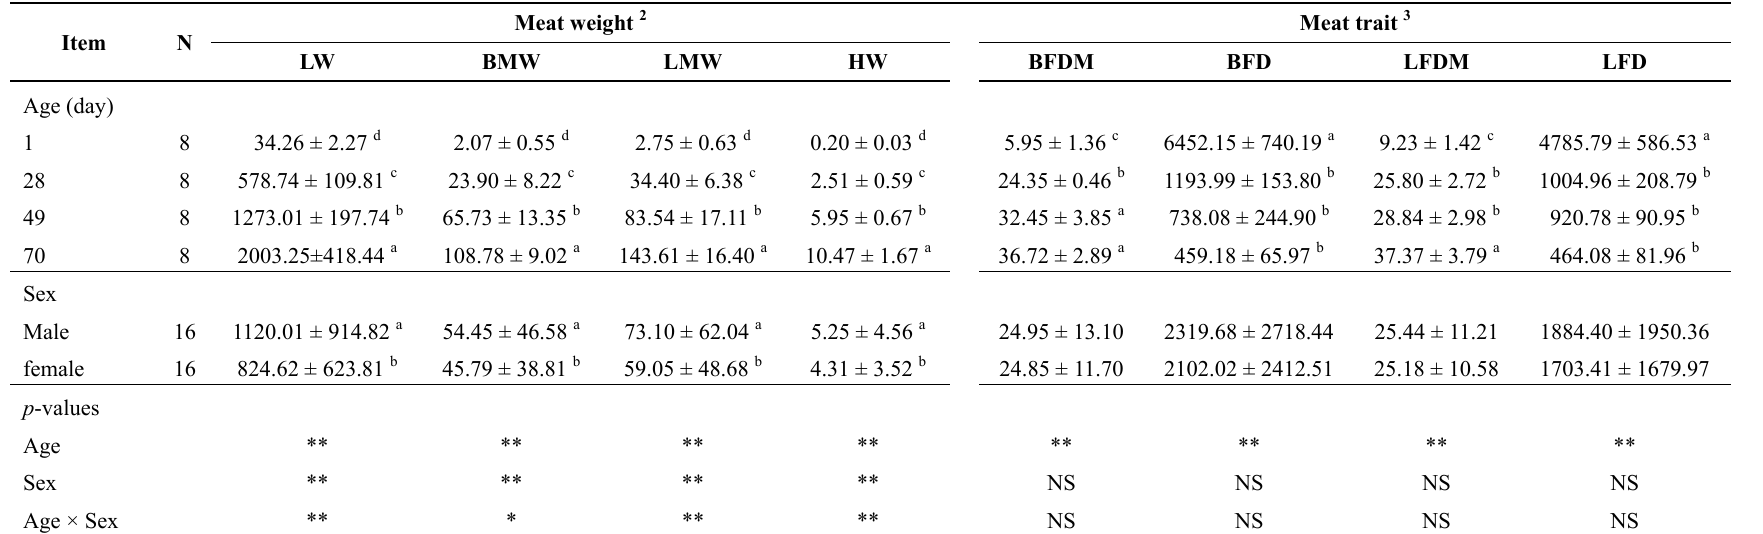
Table 1. Meat traits by age, sex and the interactions between them 1 .